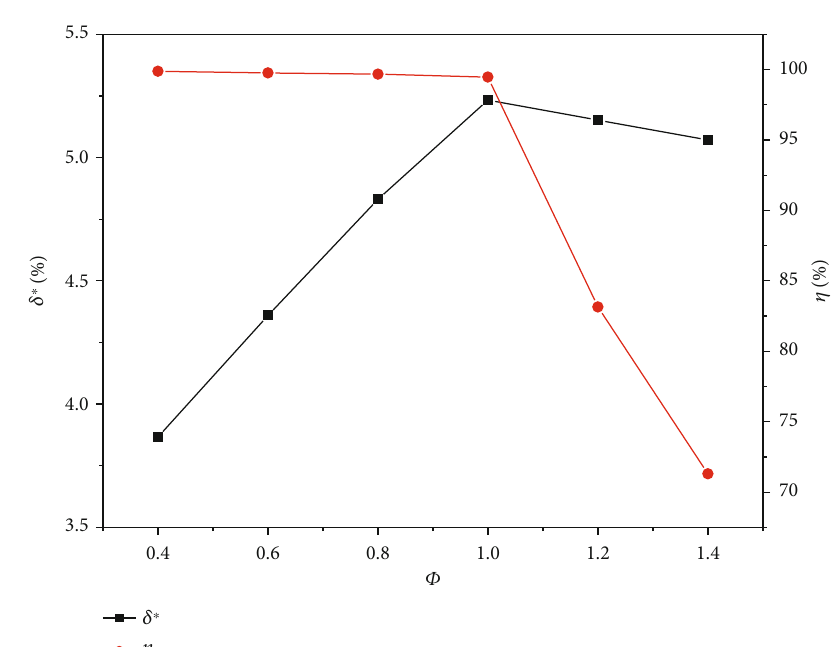
Figure 20: Total pressure loss and combustion e ffi ciency under di ff erent equivalent